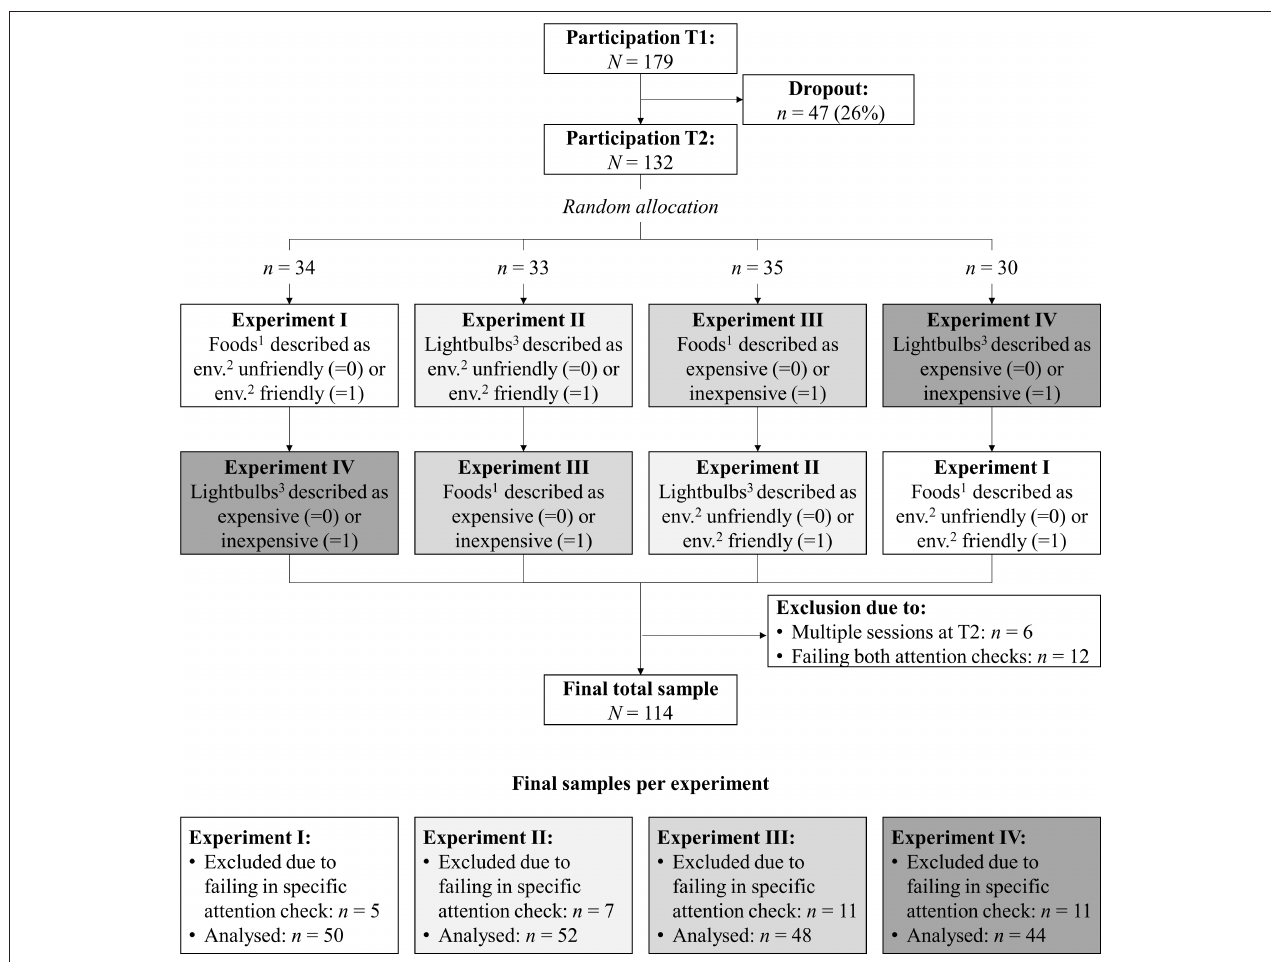
FIGURE 3 | Participant flow and sample sizes in study 1. 1 Microalgae-based foods. 2 Environmentally. 3 Nanophotonic